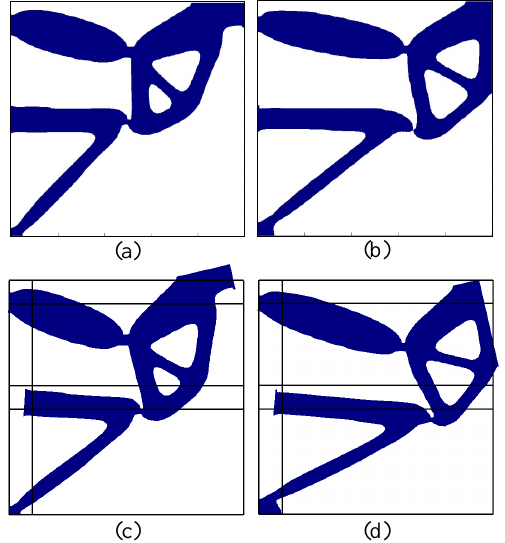
Figure 3. Compliant mechanism optimal configurations: (a) with- out displacement constraints; (c) deformed shape of (a) ; (b) with displacement constraint; (d) deformed shape of (b) .